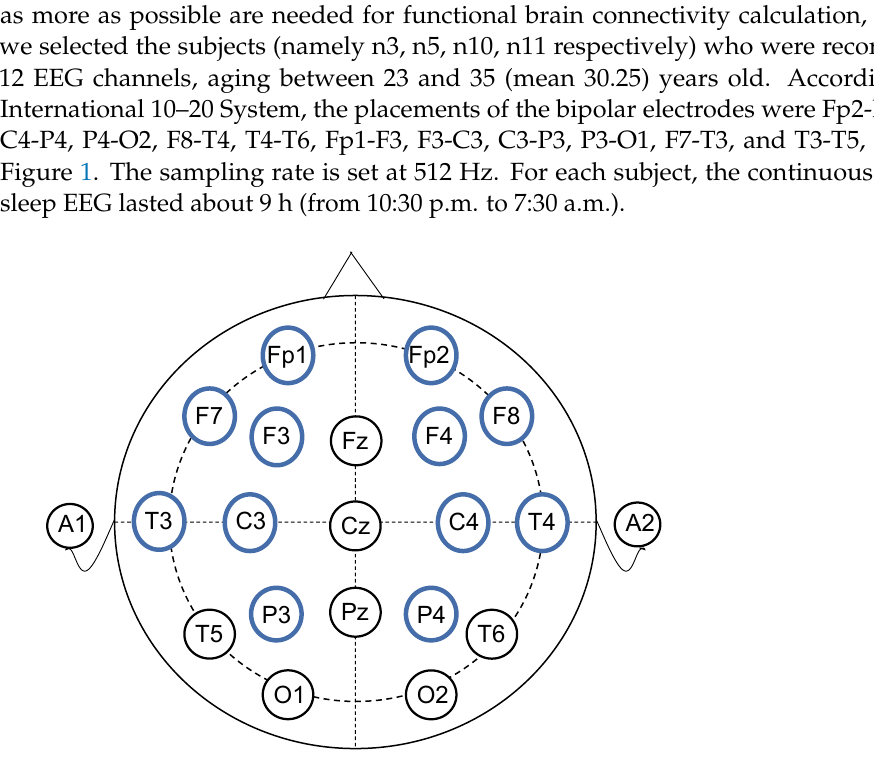
Figure 1. The layouts of EEG electrodes. The electrodes used in this study are labeled in blue